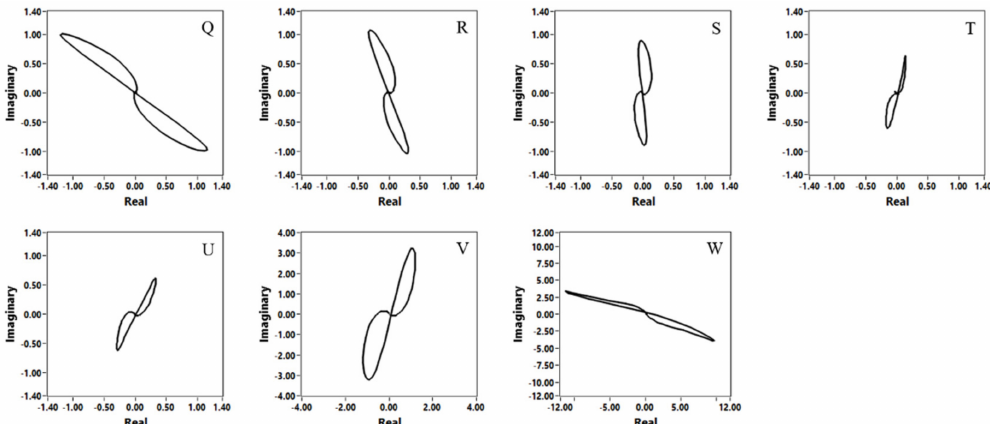
Figure 16. Lissajous curves from the front bobbin coils for the ASME standard specimen (150 kHz AC).